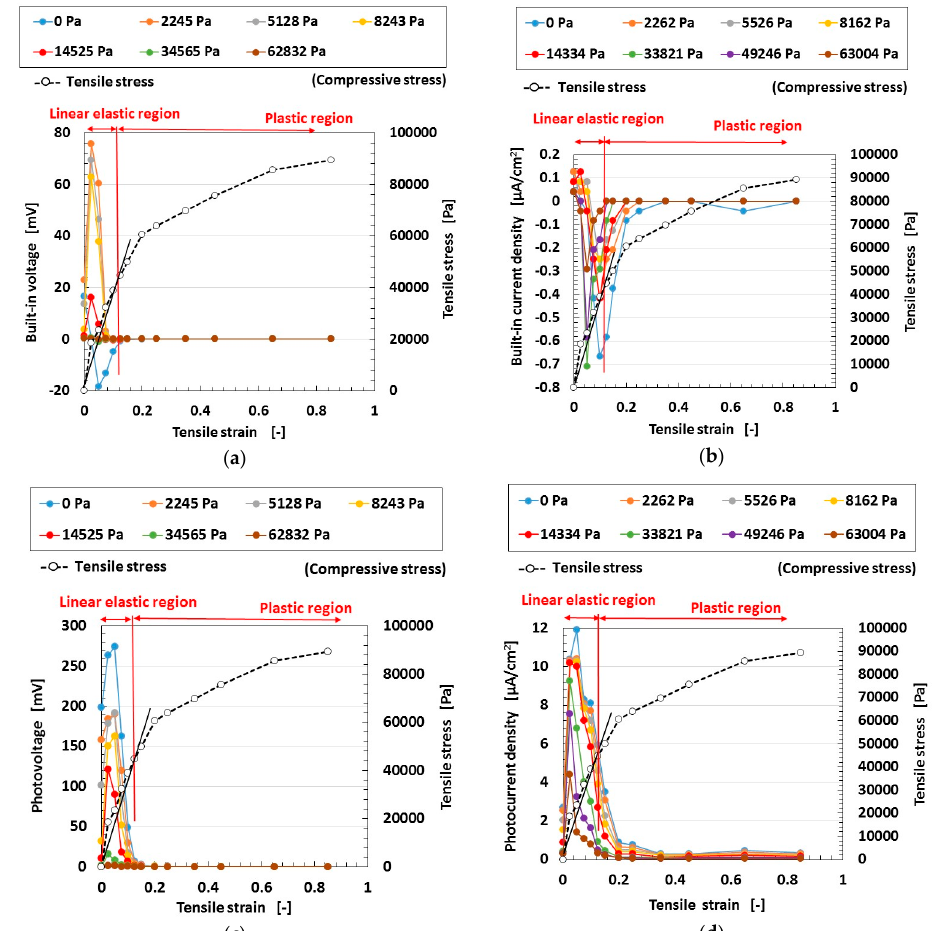
Figure 13. Changes in the effect of compression on the built-in electricity and photoelectricity under ultraviolet irradiation: ( a , b ) represent the built-in electricity; ( c , d ) represent the photo-electricity; ( a , c ) are voltage values; ( b , d ) are electric current values for wet-type MCF rubber solar cell electrolytically polymerized under a magnetic field with Ruthenium complexes dye and electrolyte KI + I 2 .